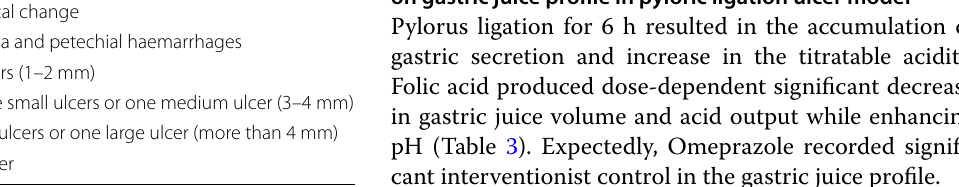
Table 2 Mucosal damage evaluation after acetic acid ulcer in rats Ulcer score Macroscopic